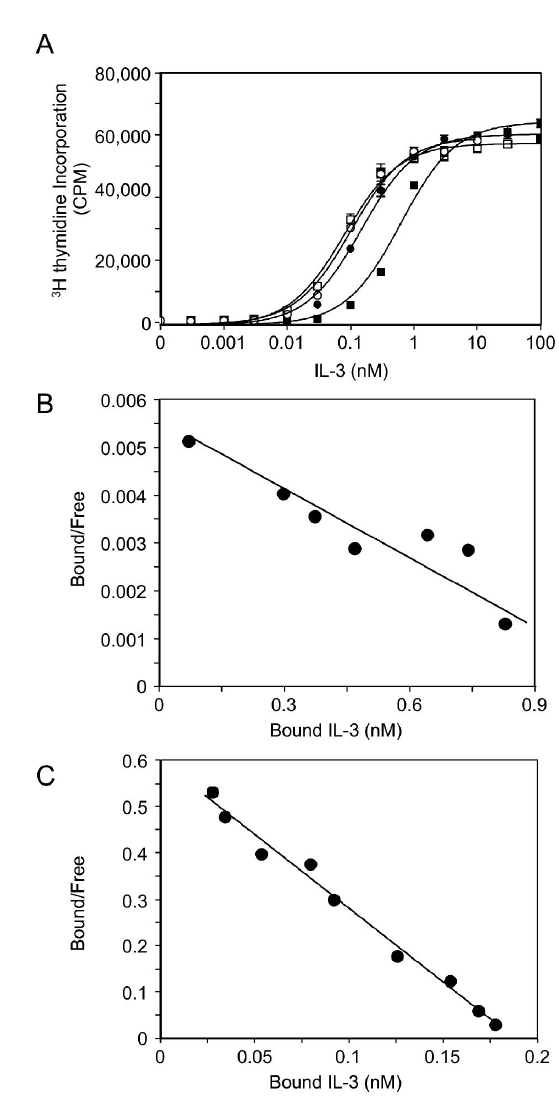
Figure 3. Functional activity of the hIL-3(13-125; W13Y) analog. A) TF-1 cell proliferation was assessed using titrations of hIL-3(13-125; W13Y) purified by SEC only (open squares) or purified by SEC plus RP-HPLC (open circles). As controls, commercial recombinant hIL-3 from supplier A (black circles) and B (black squares) were also included. Each value represents the mean of triplicate determinations and error bars represent one standard deviation. Representative data is shown from n=2 experiments. B) Scatchard plot showing 125 I-hIL-3(13-125; W13Y) binding to COS cells transiently expressing IL3Rα only. Data are from a representative binding experiment (n = 4) showing the line of best fit for IL-3 binding. C) Scatchard plot showing 125 I-hIL-3(13-125; W13Y) binding to COS cells transiently co-expressing IL-3Rα and βc. Data is from a representative binding experiment (n = 6) showing the line of best fit for IL-3 binding. Binding data for panels B and C were analyzed using EBDA-LIGAND software